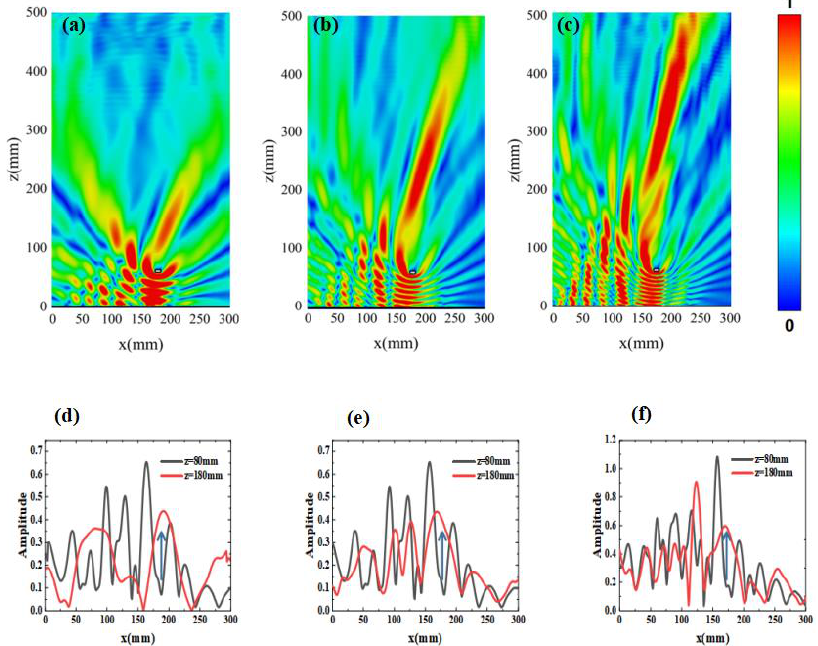
Figure 6. The self-healing properties of Airy beams: the result of the main beam deflection of an Airy beam with an obstacle (rectangular metal obstacle of 10 mm × 6 mm placed on the main lobe propagation path); ( a – c ) self-healing properties of Airy beams verified through simulation in complex environments containing obstacles; the simulated amplitude distribution on the xoz plane at frequencies of ( d ) 10 GHz, ( e ) 15 GHz, and ( f ) 20